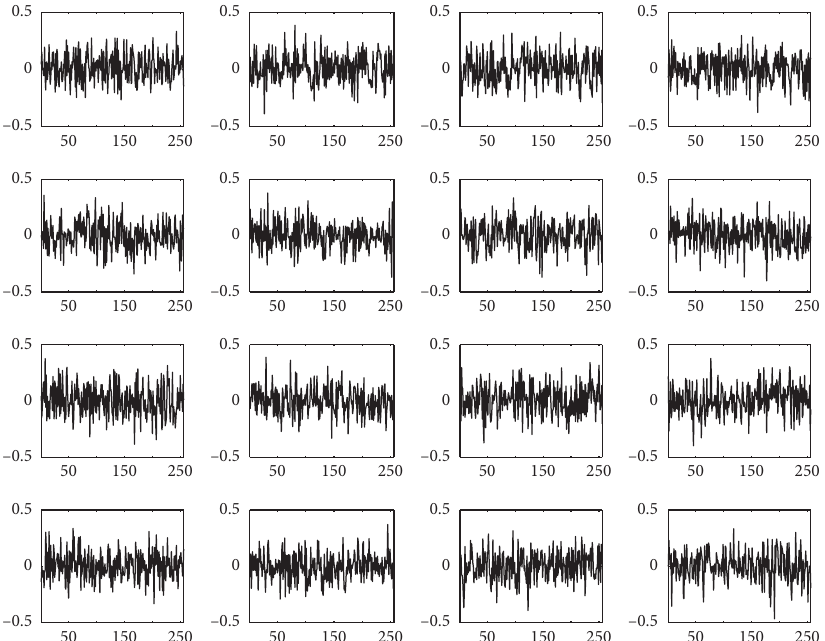
Figure 3: Part of the learned dictionary atoms by using the IKSVD method on the signal as shown in Figure 1(b).